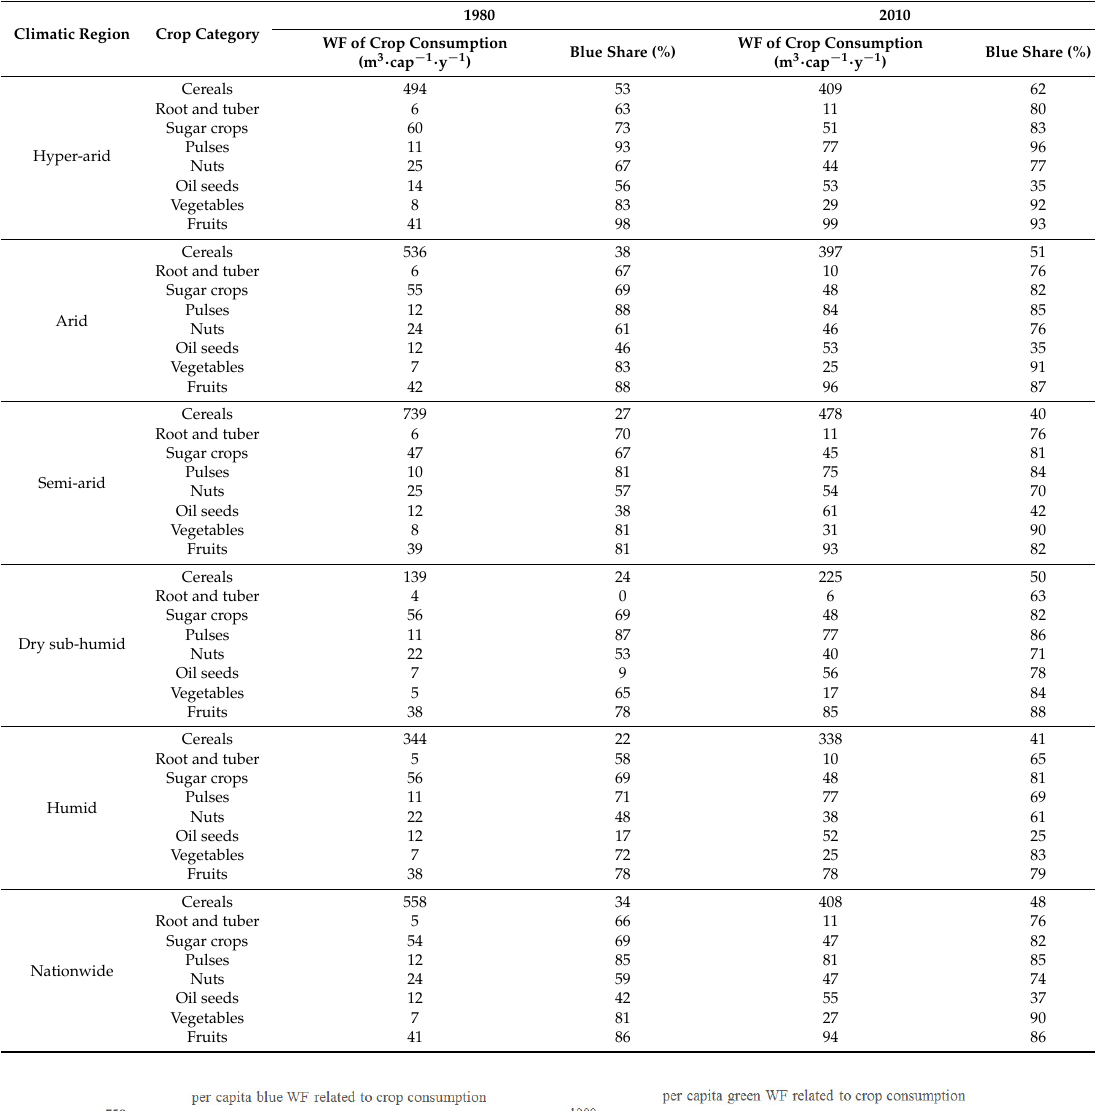
Table 3. Regional and national averages of the water footprint of crop consumption in Iran per capita and the blue share in the total, per crop category, for the years 1980 and 2010.